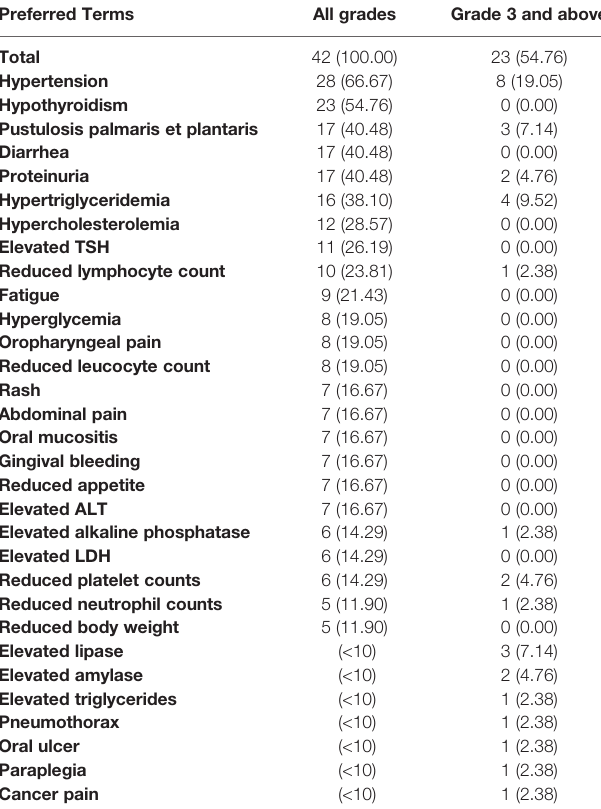
TABLE 3 | Adverse events (AEs) with an incidence ≥ 10% and grade 3 and above AEs. Preferred Terms All